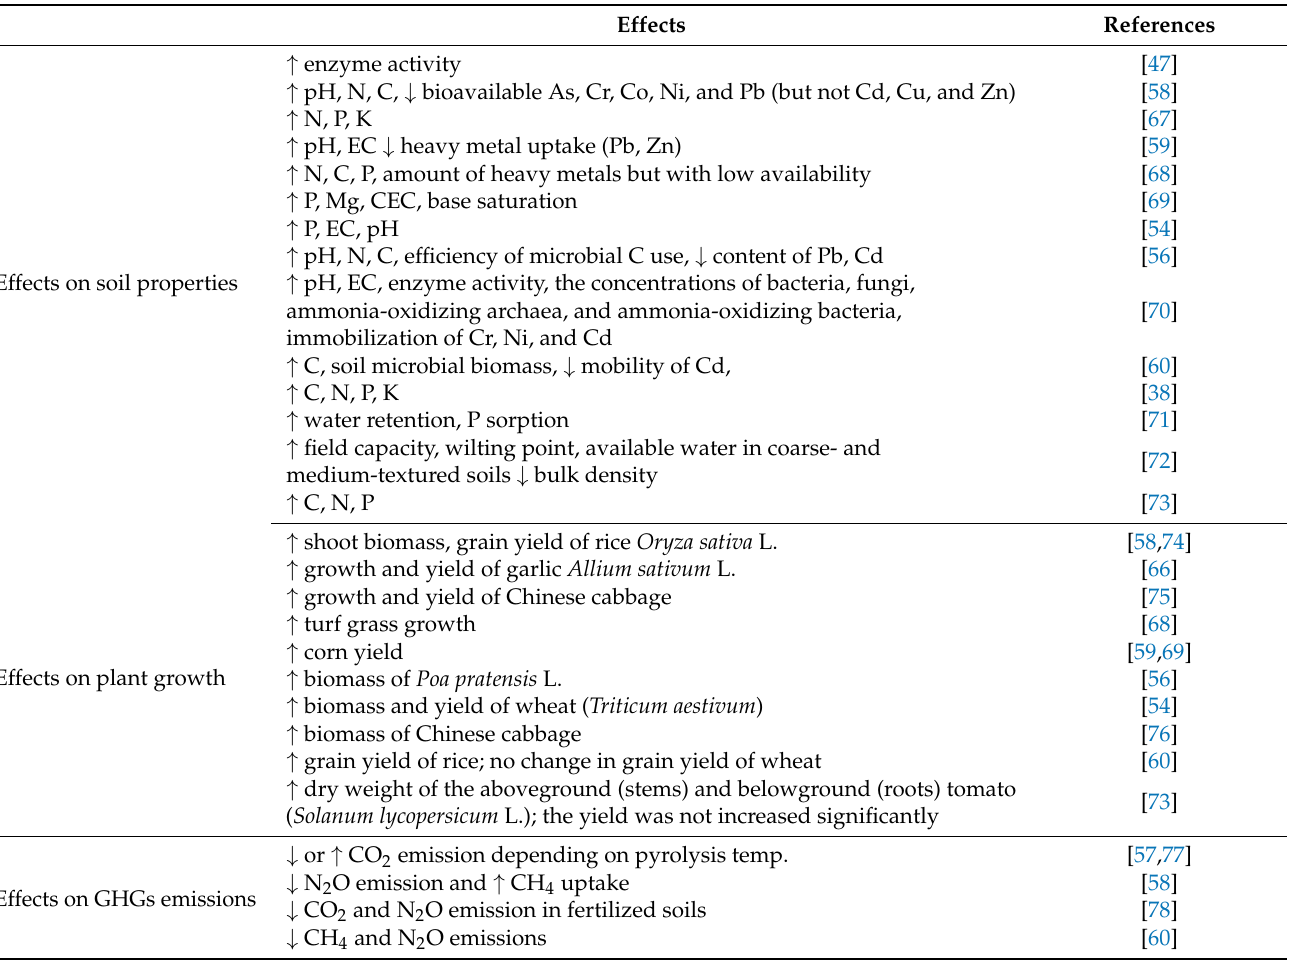
Table 2. Summary of selected data on SSB effects from environmental